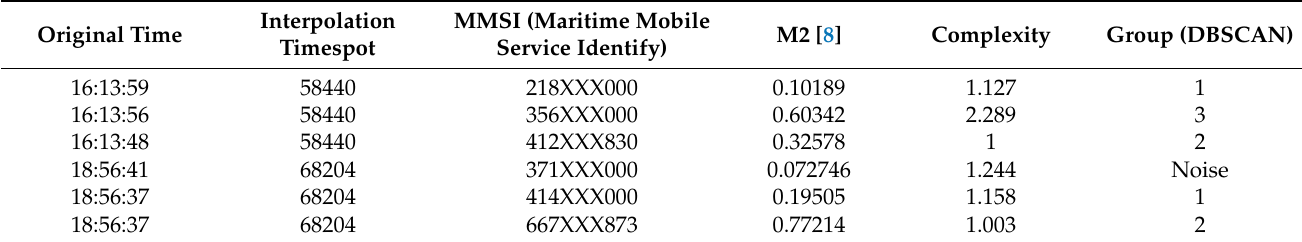
Table 3. Results of collision risk analysis using the method proposed by